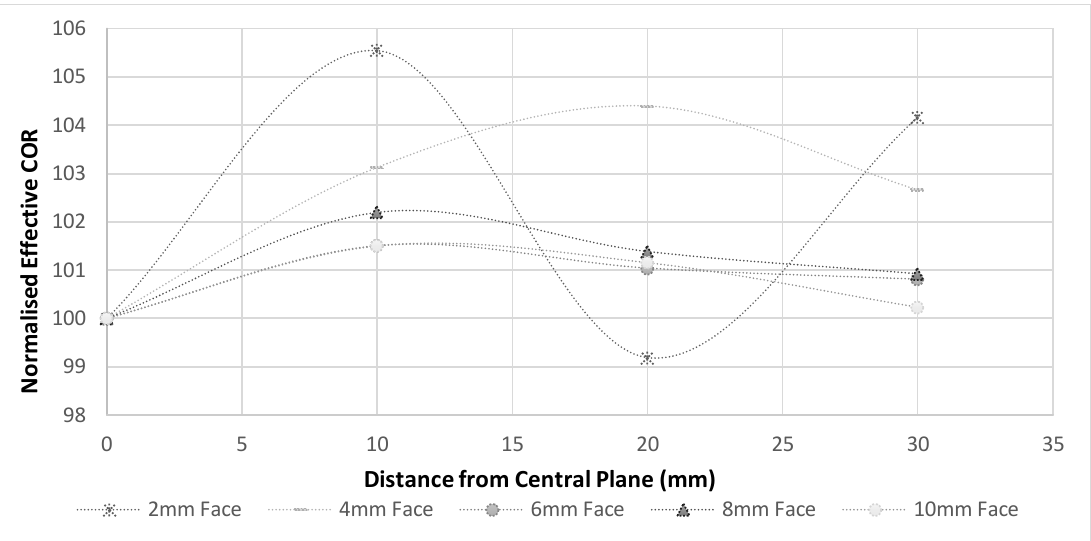
Figure 3. Variation in effective COR across the putter face, for each of the face thicknesses